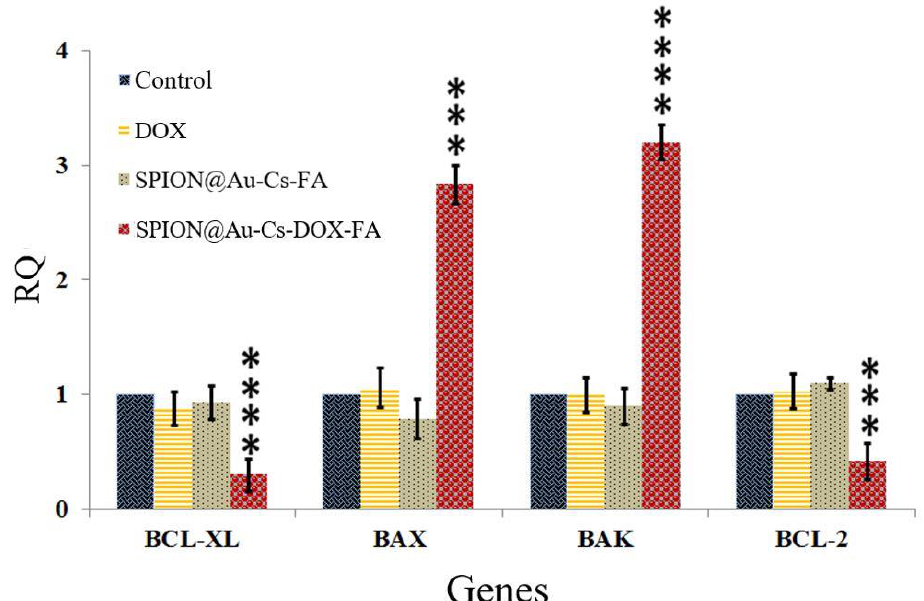
Figure 6. Gene expression of BCL-XL, BAX, BAK, and BCL-2 have been analyzed in four groups of SkBr3 cells. In each group, the first column represents control cells, the second column for cells treated with DOX, the third column for cells treated with SPION@Au-CS-FA, and the fourth column for cells treated with SPION@Au-CS-DOX-FA. The values in the graph indicate the mean ± SD. *** p < 0.001, **** p < 0.0001 represent significant differences between the control (untreated) and other treatments.